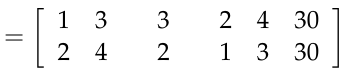
Figure 3. The results of the VMD component obtained from the numerical simulation of the sensor.